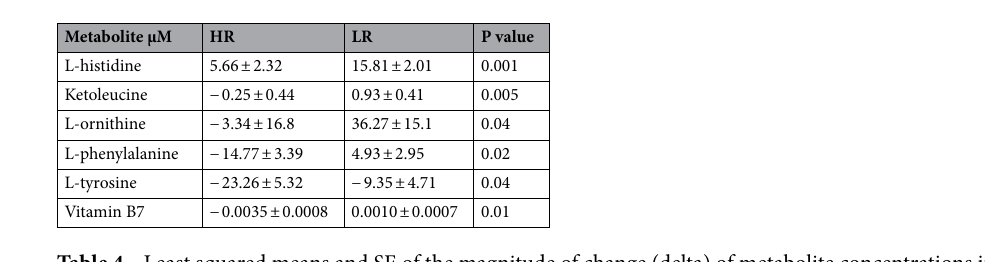
Table 4. Least squared means and SE of the magnitude of change (delta) of metabolite concentrations in pigs with high resisting (HR) and low resisting (LR) coping styles after regrouping at 9 weeks of age.